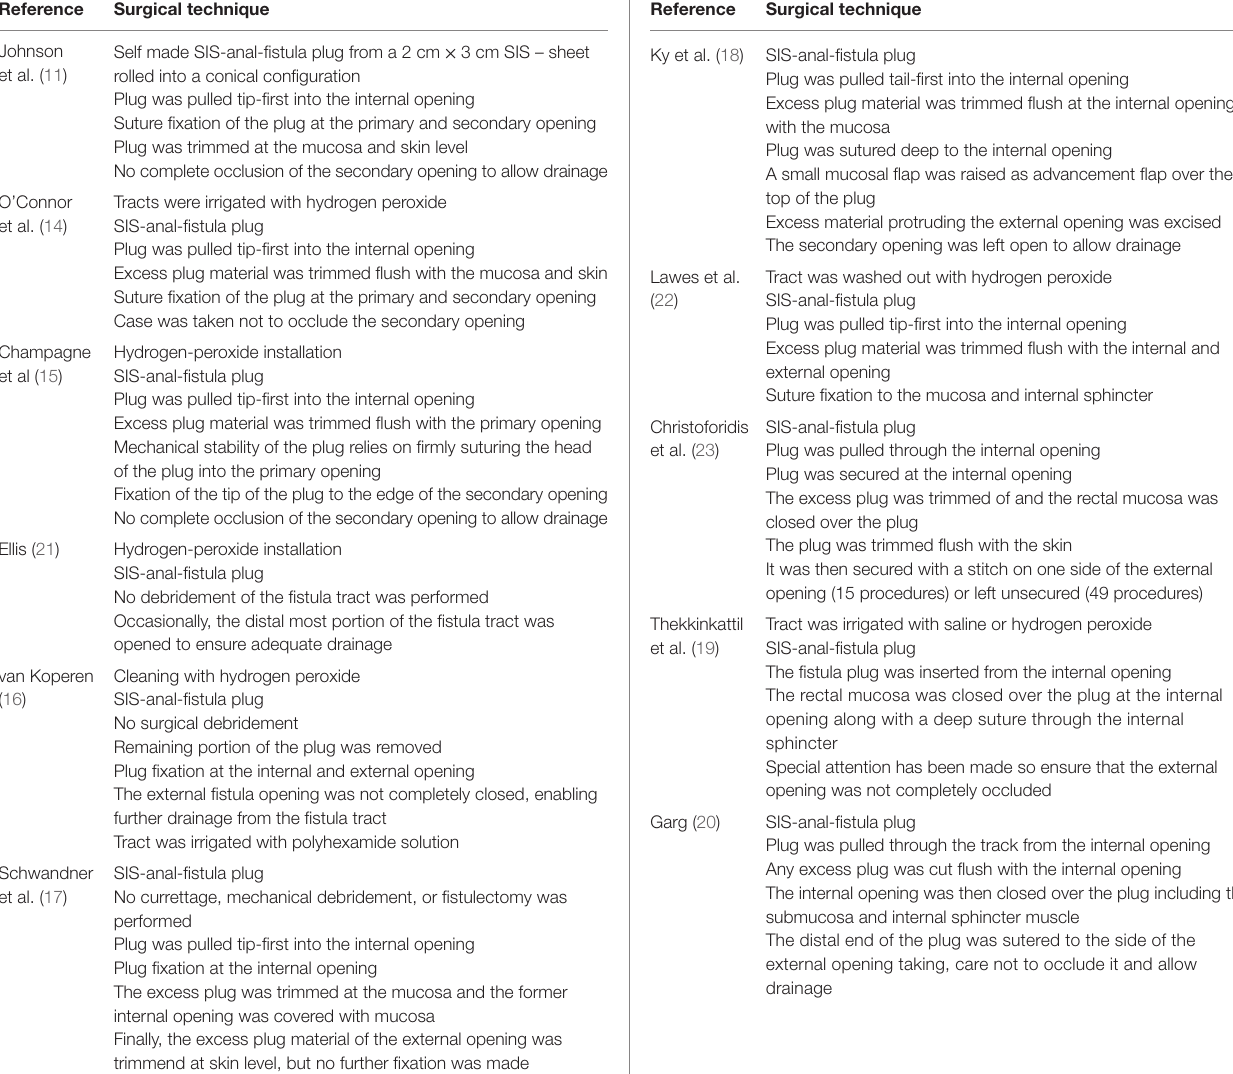
TABLe 2 | Surgical techniques used in the studies included in the systematic review of Garg et al. (13). Reference Surgical